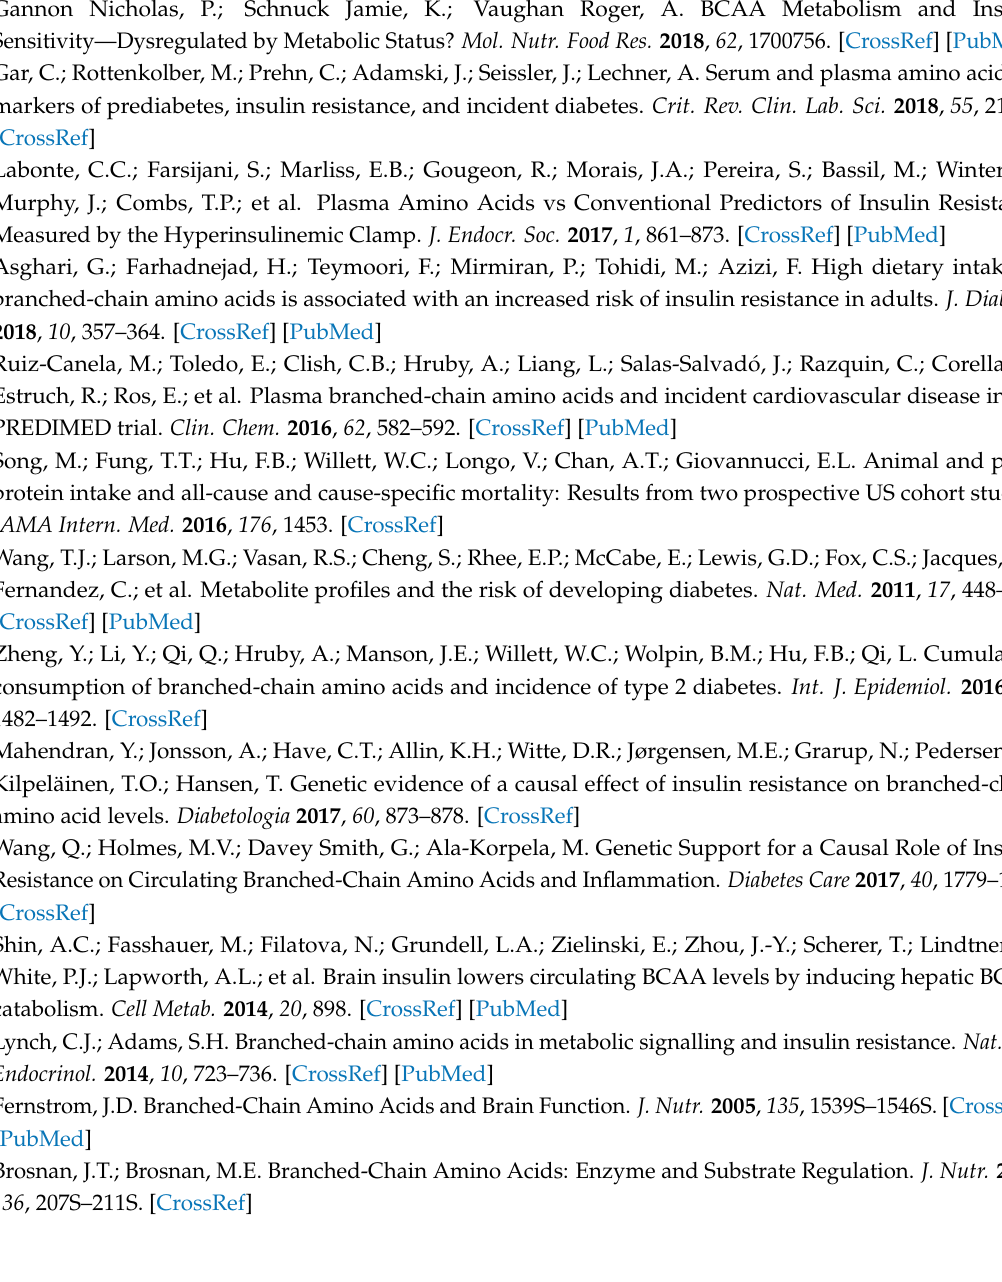
Table S1: Food grouping used in the dietary pattern